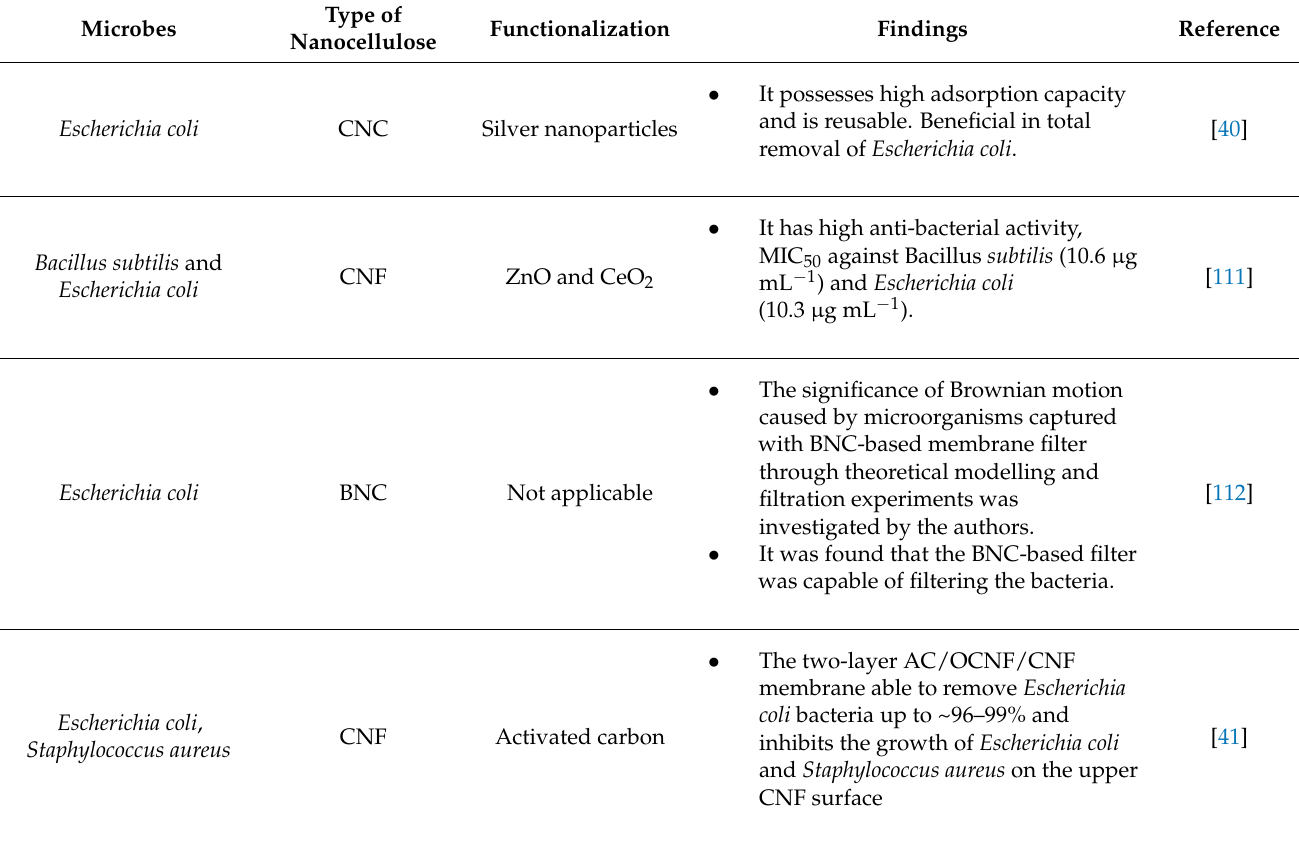
Table 8. Nanocellulose developed filtration material for bacterial